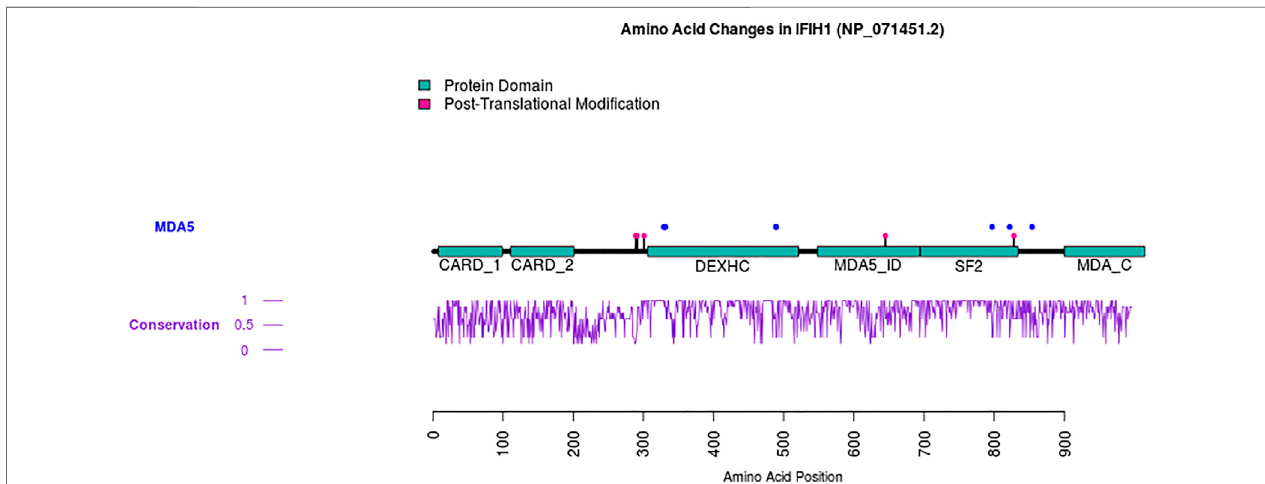
FIGURE 2 | Visualization of the SMGRT1 mutations in MDA5. Plots of all disease-causing mutations in MDA5 associated to SGMRT1. The conservation score is between 0 and 1, with 0 indicating no other sequences matching the reference ( Homo sapiens NP_071451.2) at the position, and 1 indicating all sequences